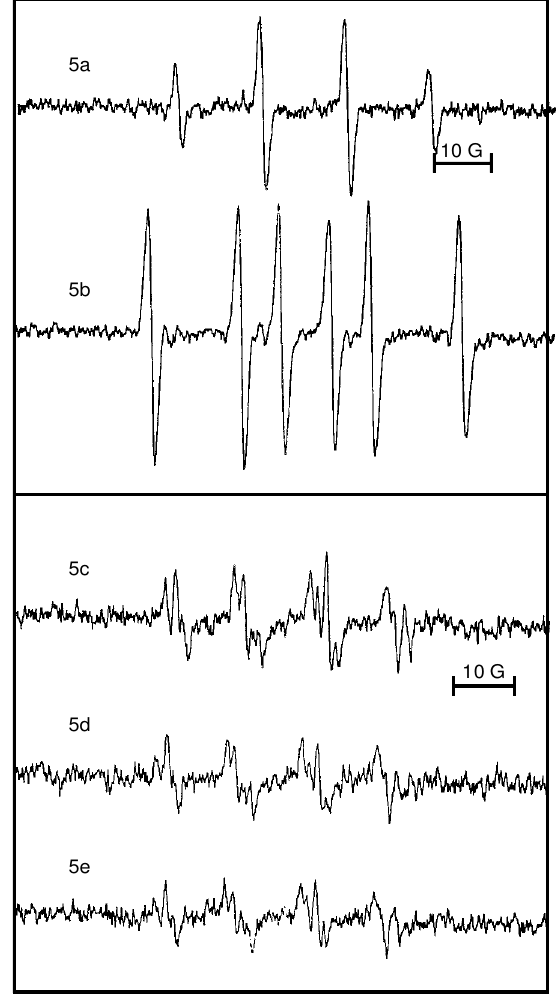
FIG. 5. ESR spectra (DMPO 100 mM) of the spin adduct of hydroxyl radical generated by the Fenton reaction [H 2 O 2 (88 mM), Fe 2 + (0.01 mM), EDTA (0.01 mM) (a and b) and superoxide spin adduct generated by xanthine (50 mM) / xanthine-oxidase (110 mU / ml) system in HBSS buffer pH 7.4 (c, d and e). (a) Normal spectrum (hyper® ne